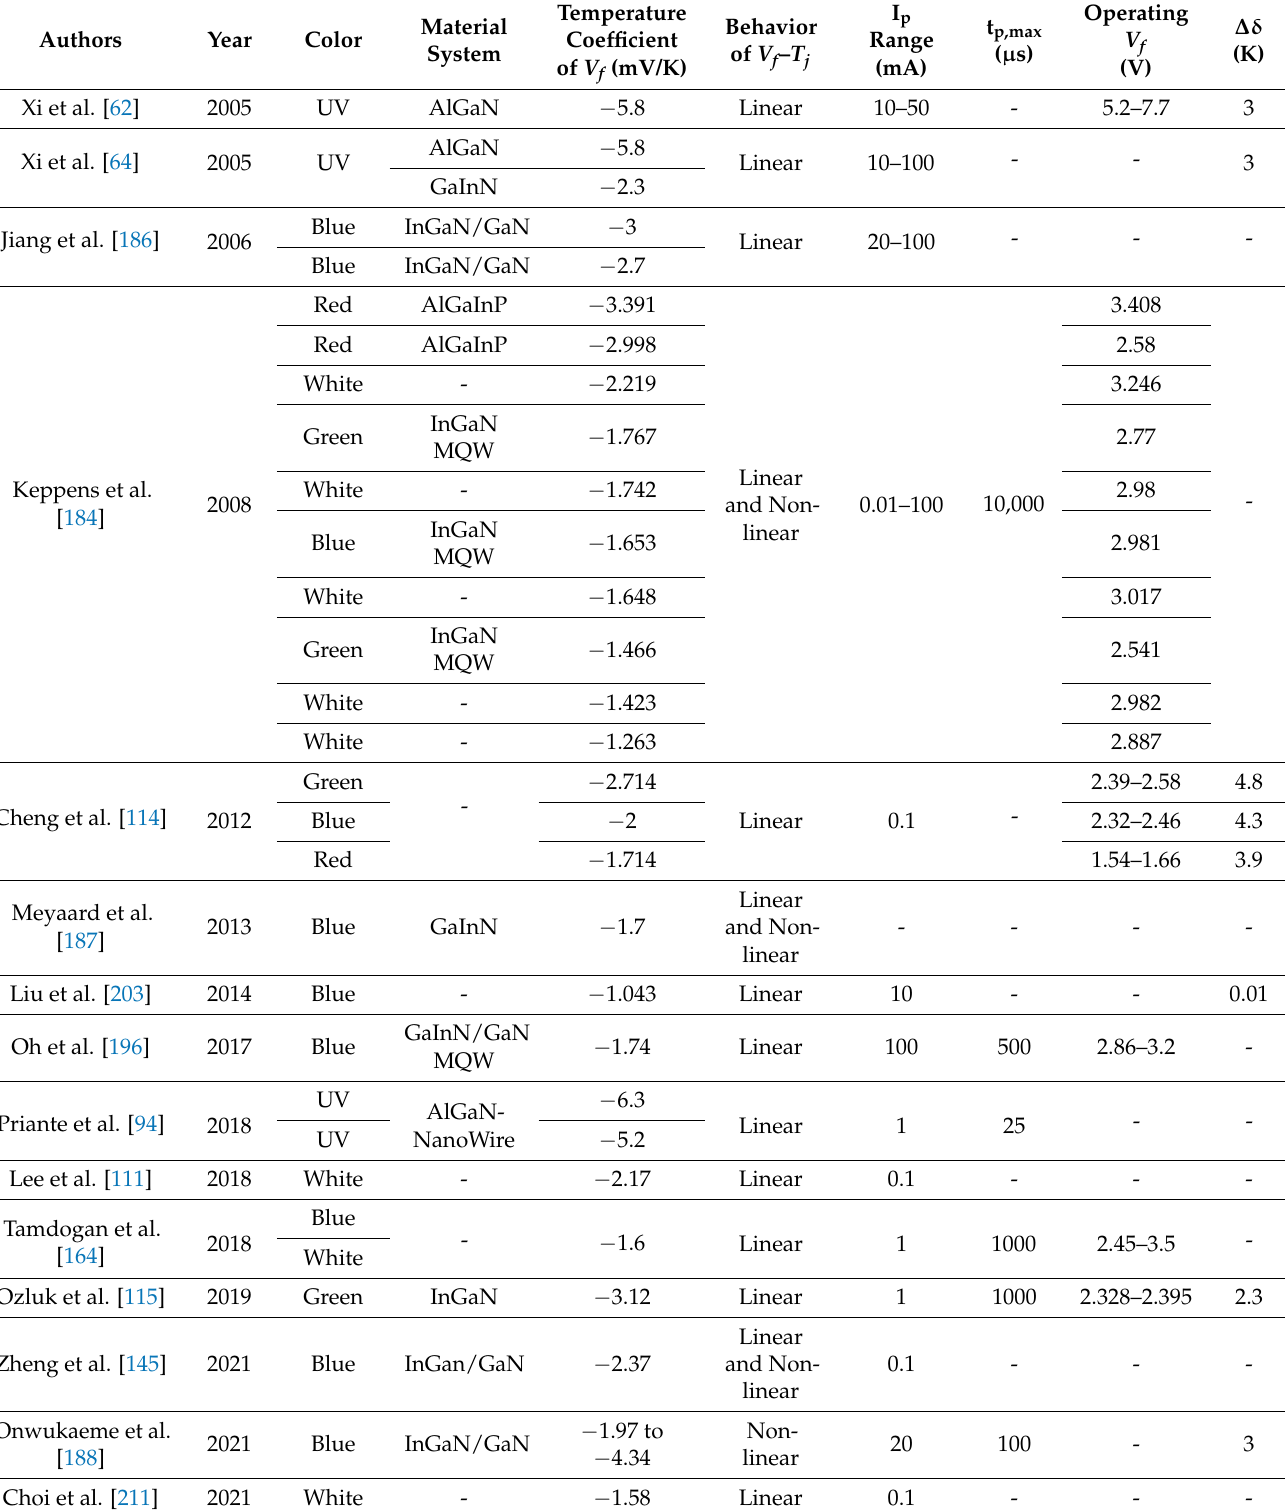
Table 4. FVM parameters that are employed in the literature for T j measurement of LEDs. References are sorted by year. Not reported parameters are indicated by a hyphen in the table. ( I p : pulse